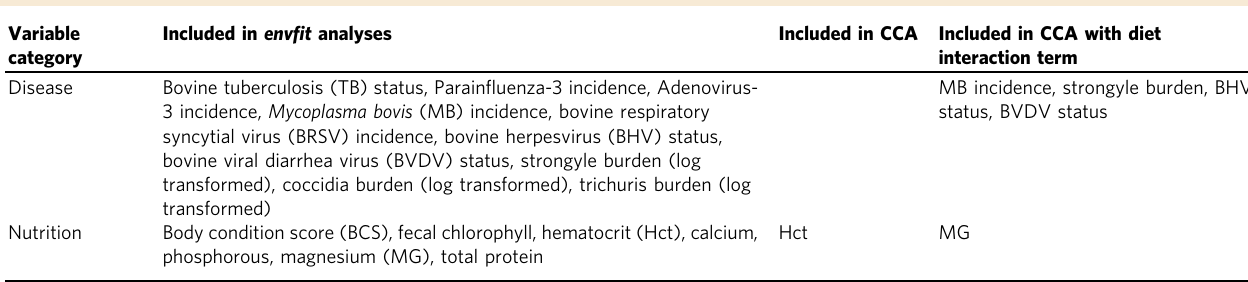
Table 3 Host covariates included in the variable selection process and retained for downstream CCA